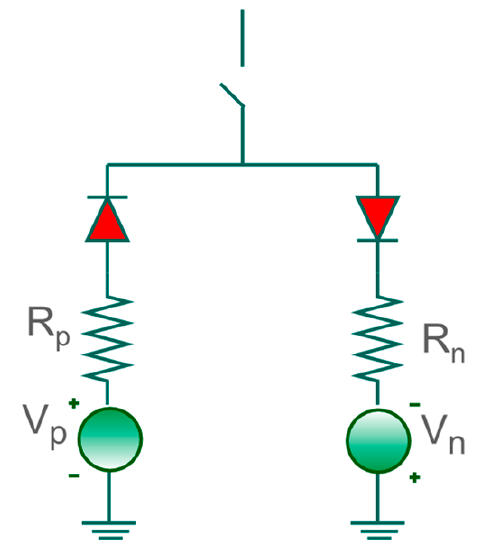
Figure 2. Model adopted for HIF [23].